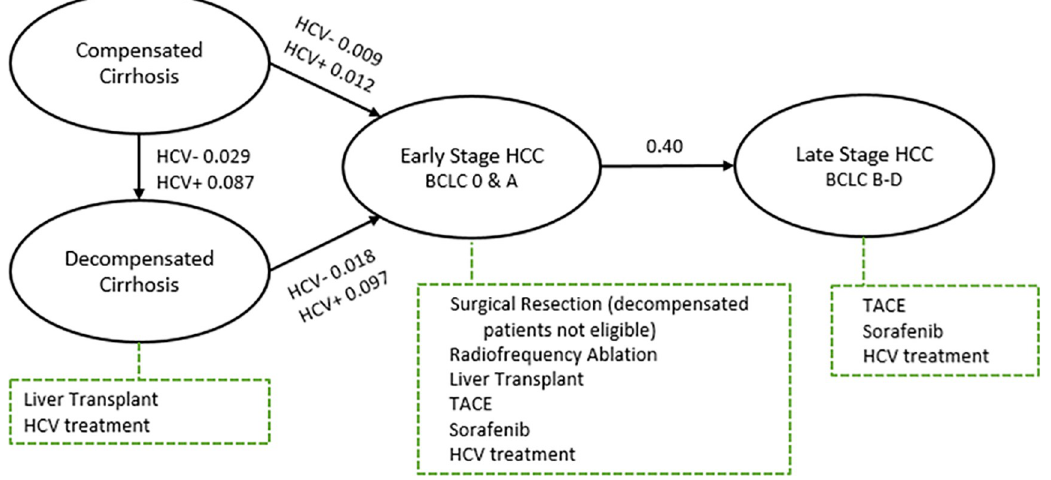
Fig 2. Progression of HCV related compensated cirrhosis and stage-specific treatments. BCLC = Barcelona Clinic Liver Cancer staging classification, HCC = hepatocellular cancer, HCV = hepatitis C virus, and TACE = transarterial chemoembolization. The diagram illustrates how disease progression and stage-specific treatments for HCC are simulated in the model. Numeric values indicate the annual rate of transition with and without HCV.